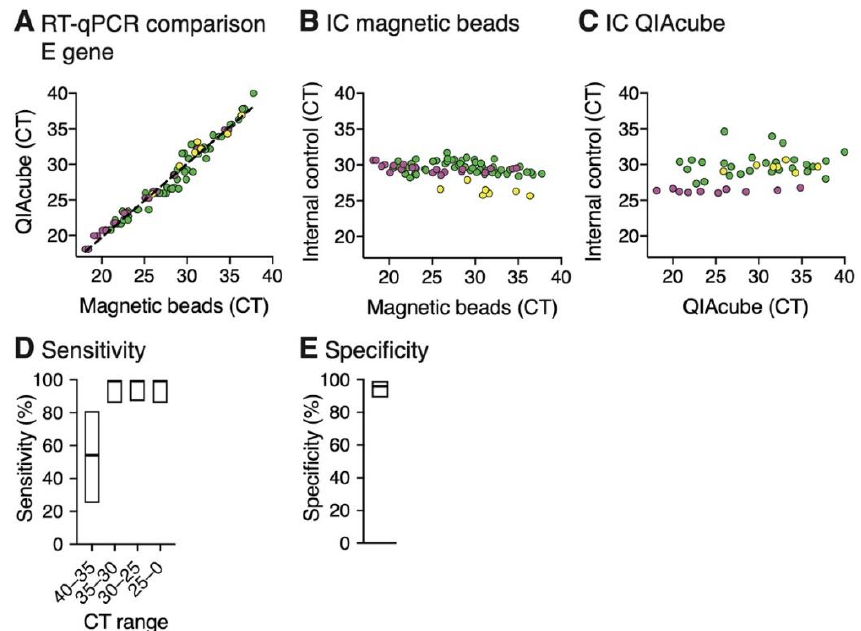
Figure 4. RT-qPCR of RNA extracted from SARS-CoV-2 positive patient samples using magnetic bead RNA extraction and QIAcube RNA extraction. RNA extraction was performed on three sets of SARS-CoV-2 positive patient samples with a total sample number of 82 (yellow = 7 samples, magenta = 20 samples, green = 55 samples) in parallel with either the magnetic bead RNA extraction protocol or the automated QIAcube extraction kit and further analyzed by RT-qPCR using the E gene. ( A ) Comparison of RT-qPCR analysis of RNA extracted by the two different extraction methods. The plot shows the E gene CT values for each sample. A linear regression (equation: f(x) = 1.037x − 1.013, R 2 = 0.967) is plotted as a dashed line. ( B , C ) Analysis of the internal control of the RT-qPCR for RNA extracted by the magnetic bead RNA extraction protocol ( B ) or QIAcube extraction kit ( C ). Plots show the CT values of the internal control plotted against the E gene CT values. ( D , E ) Sensitivity ( D ) and specificity ( E ) analyzed by RT-qPCR of the three independent magnetic bead RNA extractions. To determine sensitivity and specificity, QIAcube RT-qPCR results were used as a reference. RT-qPCR after magnetic bead RNA extraction provides close to 100% sensitivity and specificity at a cutoff CT of 35. Data are shown as mean with indicated 95% Clopper–Pearson confidence intervals (Supplementary Table S1).